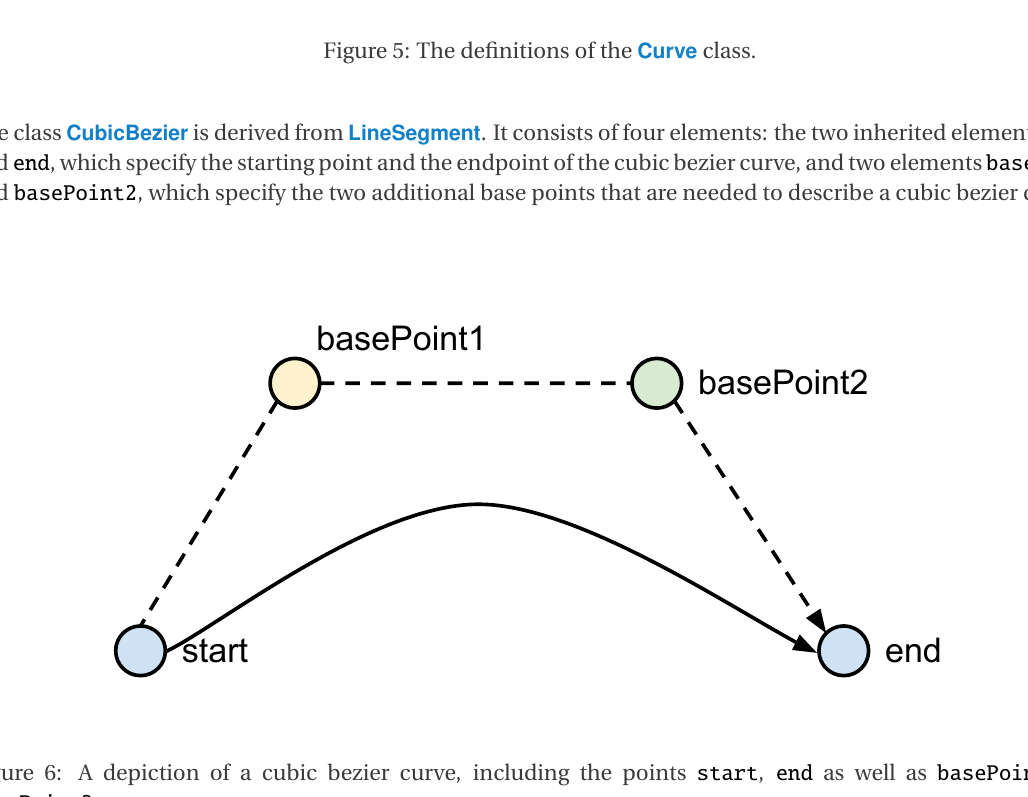
Figure 6: A depiction of a cubic bezier curve, including the points start , end as well as basePoint1 and basePoint2